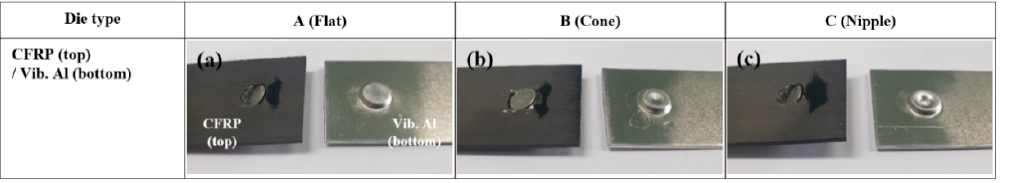
Figure 14. Failure modes for the self-piercing riveted joint formed between vibration-damping Al and CFRP with respect to the die type: ( a ) die type A , ( b ) die type B , and ( c ) die type C .